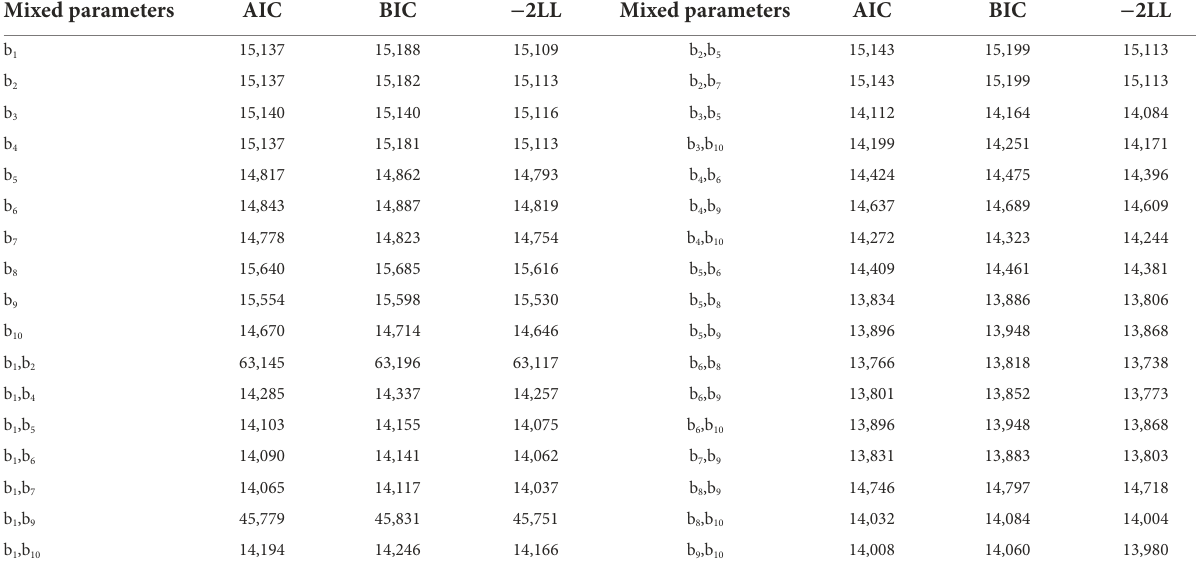
TABLE 6 Statistics of the AIC, BIC and − 2LL for Kozak (2004) variable-exponent taper models with the density effect. Mixed